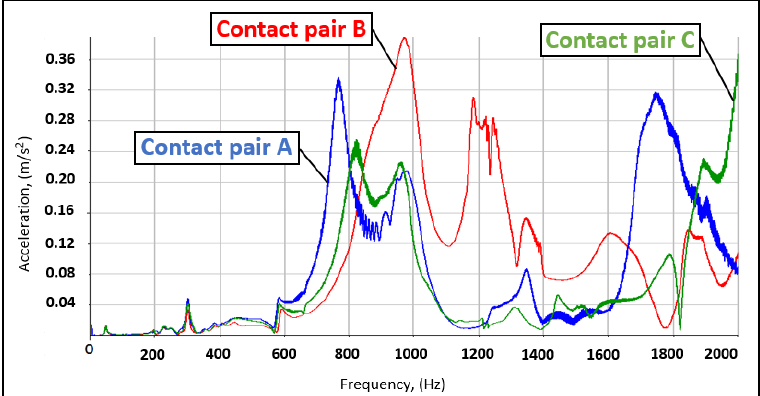
Figure 8. Dynamic response of the reading head to an external mechanical excitation.